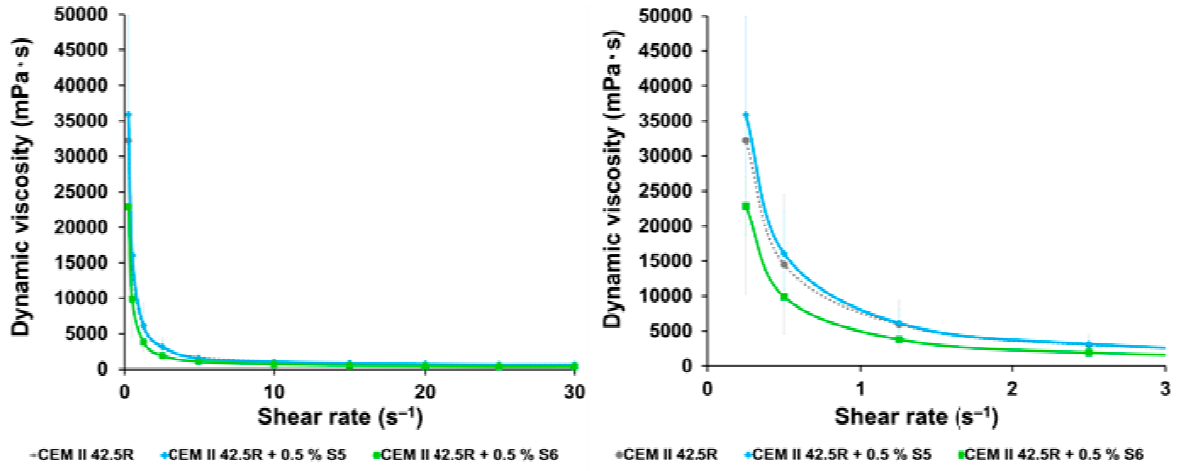
Figure 4. Investigation of dynamic viscosity ( left ) full graph, ( right ) enlargement) of the cement CEM II 42.5R at w/c = 0.5 with 0.5% of additives. Test conditions: 0.5% bwoc of SPs; w/c = 0.5; CEMII 42. 5R = 30 g (EN197-1); deionized H 2 O = 15 g.